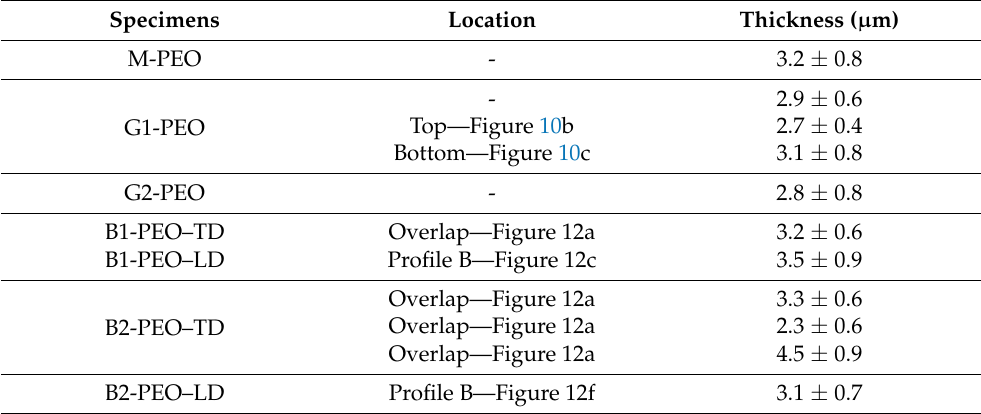
Table 6. Thickness measurements of the flash-PEO coatings on the EB-structured samples. Values obtained from cross-section images in Figure 7, Figure 10 and Figure 12,